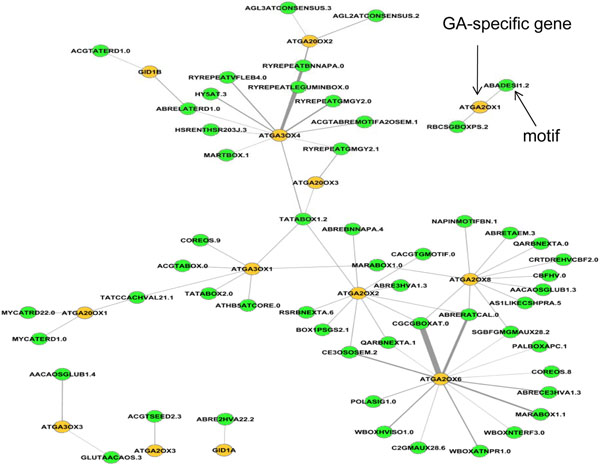
Cis-regulatory network of Arabidopsis gibberellin metabolism and signaling genes. Yellow and green nodes represent genes and cis-regulatory elements, respectively. The width of an edge is proportional to the significance of enrichment, measured by the negative logarithm of the p-value. The number after the dot following the motif name represents the number of mismatches allowed in order to obtain maximum statistical significance.